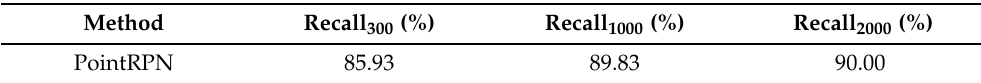
Table 6. Comparison of the detection recall results by varying the number of proposals of each image patch. The metric recall is evaluated on the DOTA-v1.5 validation set. Recall 300 , Recall 1000 , and Recall 2000 represent the detection recall of the top-300, top-1000, and top-2000 proposals, respectively.